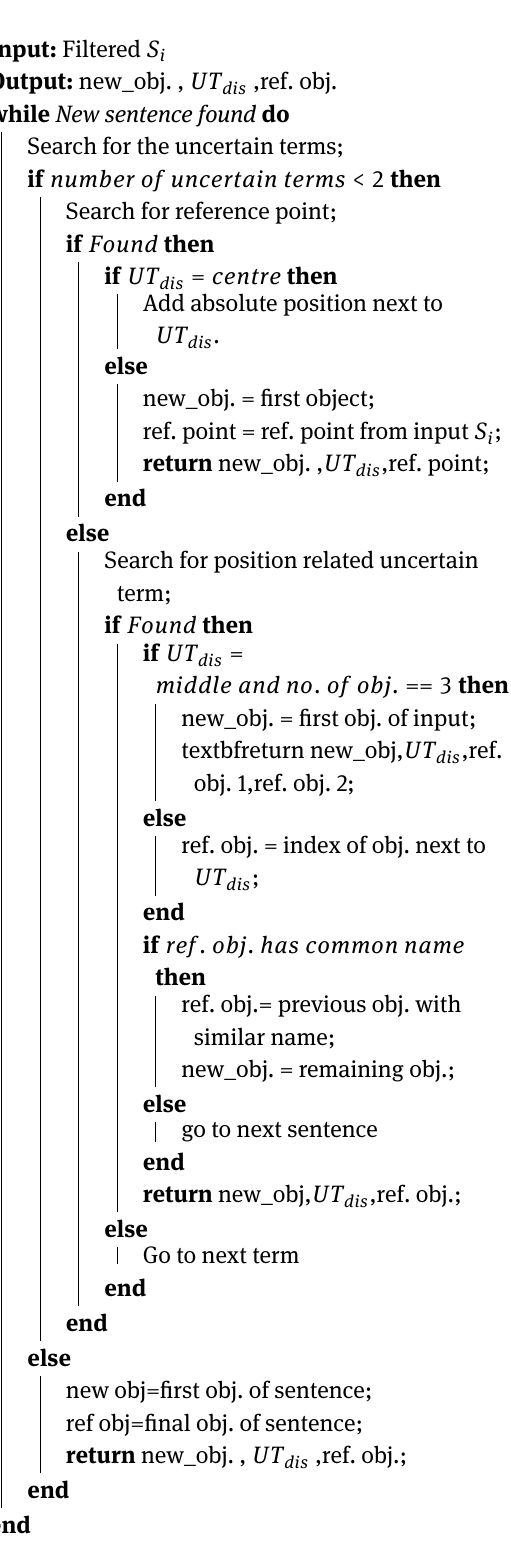
Algorithm 1: Spatial category interpretation